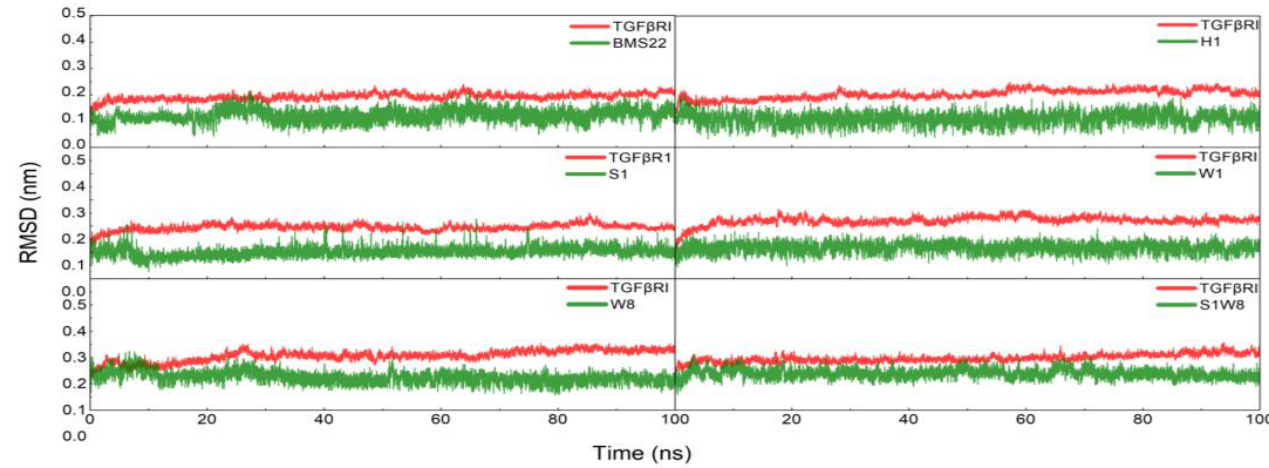
Figure 6. RMSDs of the TGFβR Ⅰ backbone and ligands’ heavy atoms of six systems during MD simulations.